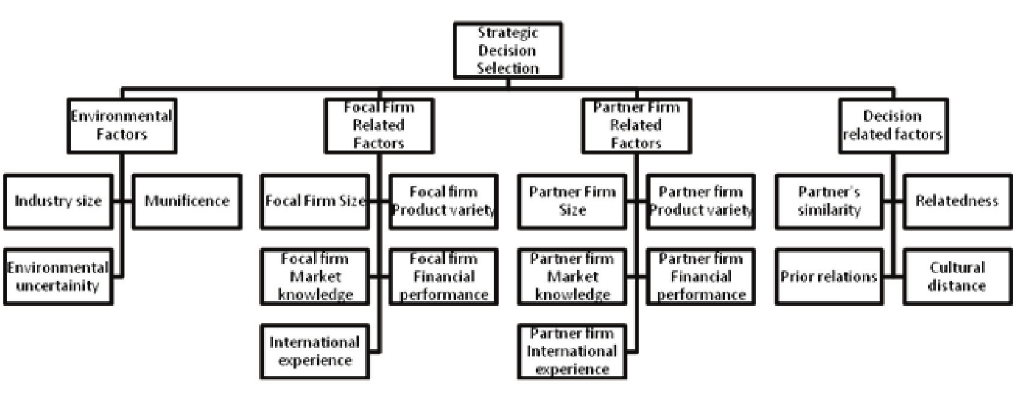
Figure 1: Strategic Decision Selection